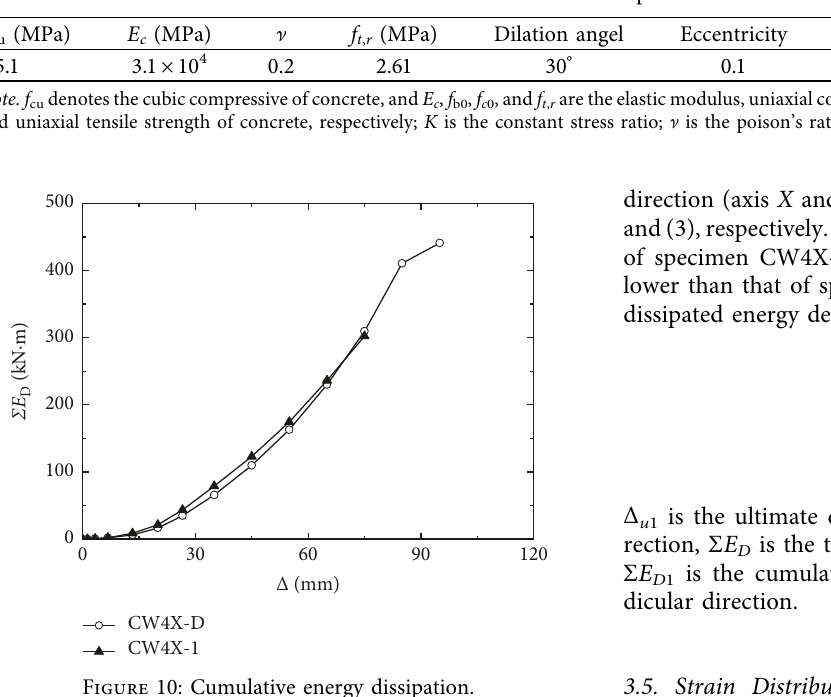
Table 3: Concrete parameters.